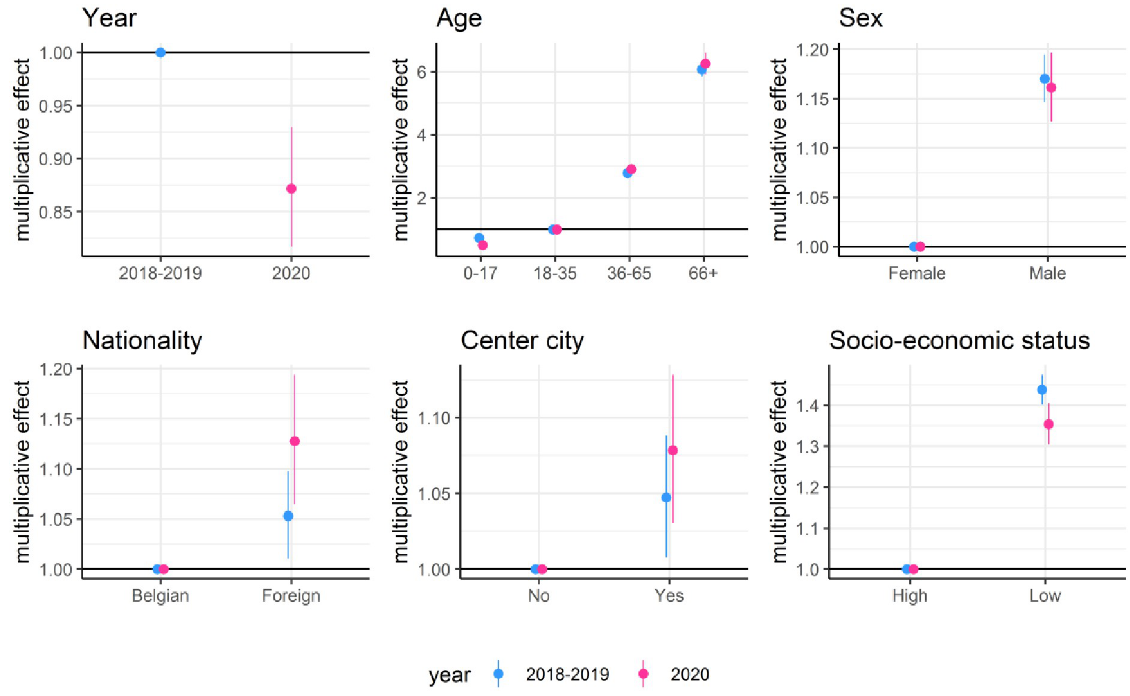
Fig 3. Multiplicative effect and associated 95% confidence intervals of covariates on the expected number of chronic diagnoses per patient per year. Separate parameters were estimated for the period February 1, 2018 to January 31, 2020 and the period February 1, 2020 to January 31, 2021 which are labeled 2018–2019 and 2020,